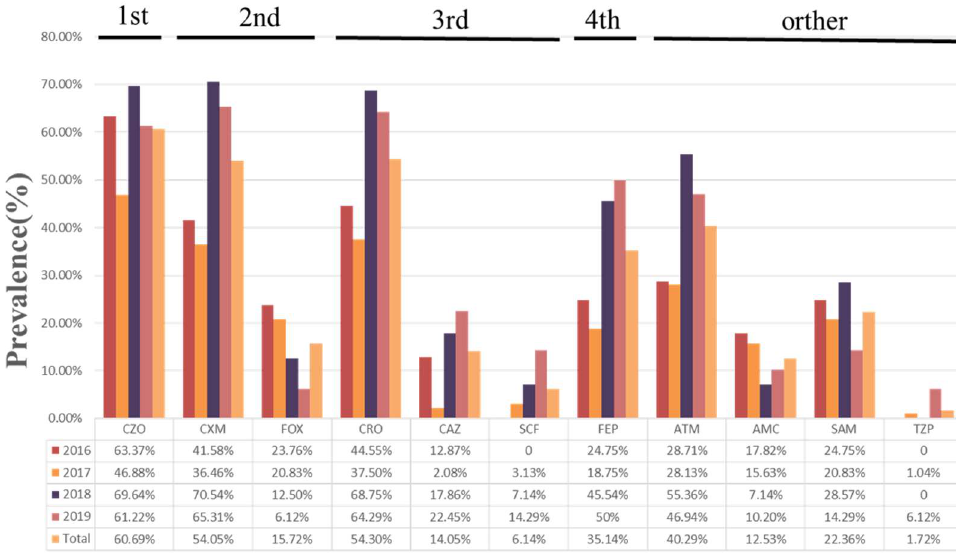
Figure 1. Antimicrobial resistance patterns in 407 E. coli isolates. First-generation cephalosporin: CZO, cefazolin. Second-generation cephalosporins: CXM, cefuroxime; FOX, cefoxitin. Third- generation cephalosporins: CRO, ceftriaxone; CAZ, ceftazidime; SCF, cefoperazone/sulbactam. Fourth-generation cephalosporin: FEP, cefepime. Other β -lactam antibiotics: ATM, aztreonam;